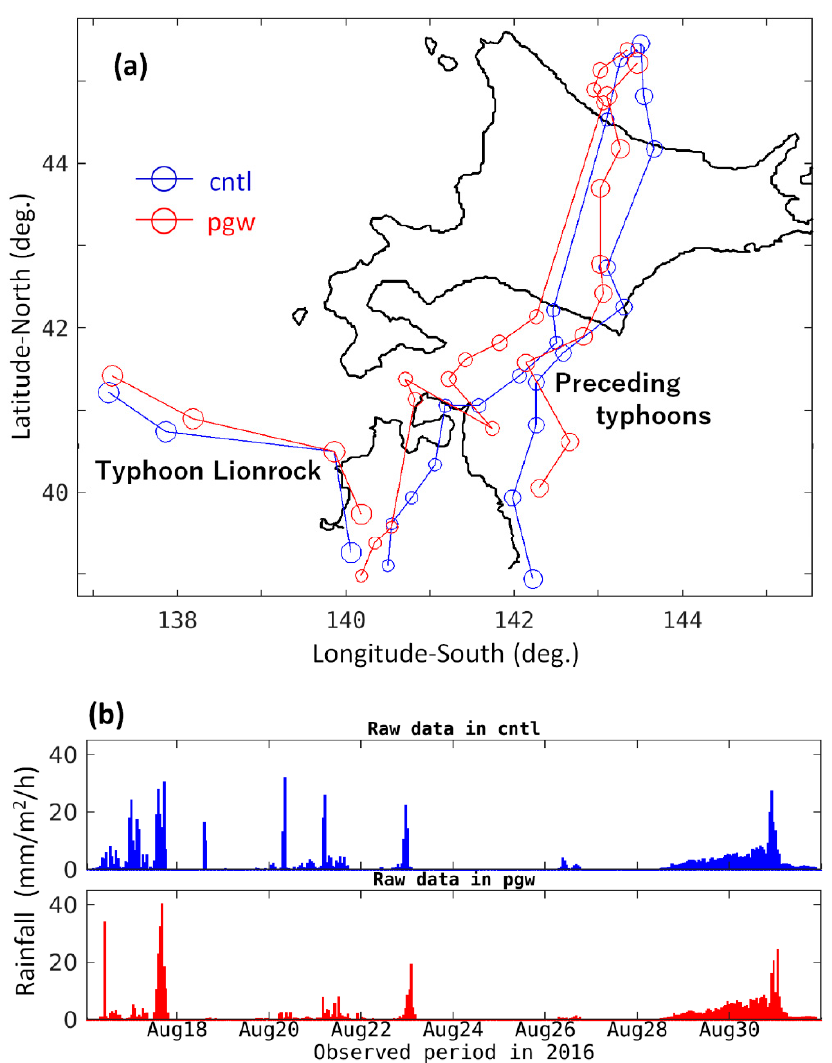
Figure 9. Features of the raw datasets of the CNTL and PGW simulations. ( a ) Possible typhoon trajectories based on air pressure < 1000 hPa but the Typhoon Kompasu’s trajectory disappeared because of higher air pressure ( > 1000 hPa) in Hokkaido, and ( b ) Mean rainfall data over an upstream area from Moiwa Station from August 15 to August 31.